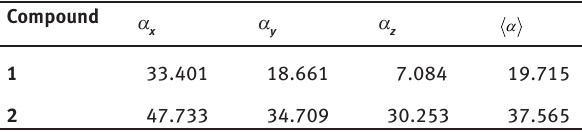
Table 2: Some selected components of the static a(0;0) and a (0;0) ( × 10 -24 esu) values for 1 - 2 computed by DFT method at B3LYP/ 6-31G( d ) level.